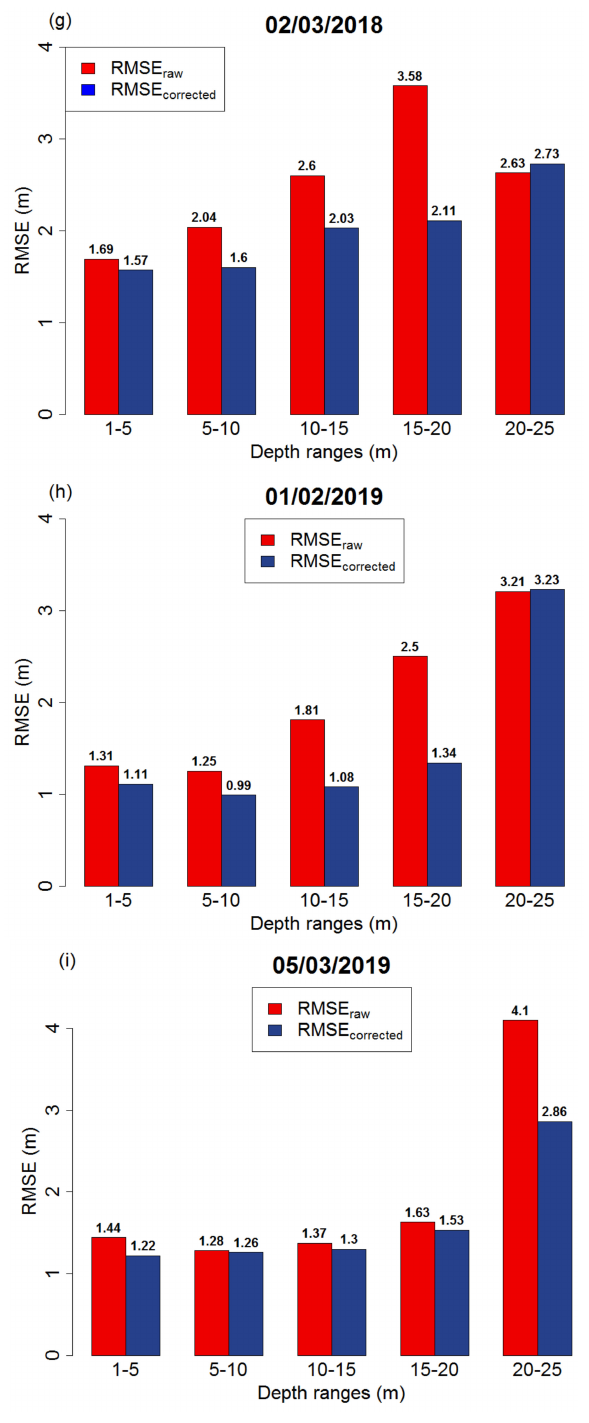
Figure 6. ( a – i ) RMSE values obtained for SDB raw and SDB corrected estimates at di ff erent water depths. Results at higher depth ( > 15 m) should be interpreted with caution, as the number of depth observations for those depth ranges was comparably lower than those available for shallower depth ranges. Depth observation for each depth range is as follows: 1–5 m: approximately 900 points, 5–10 m: approximately 1800 points, 10–15 m: approximately 300 points, 15–20 m: approximately 40 points, and 20–25 m: approximately 20 points. Note that the y-axes have di ff erent ranges for each date to facilitate comparison between RMSE raw and RMSE corrected for each single